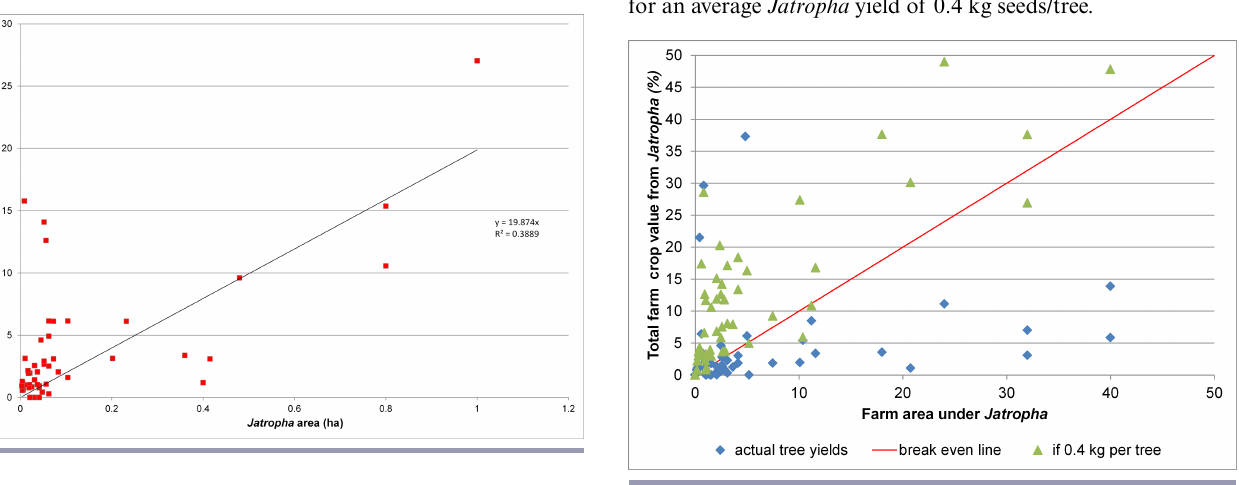
Fig. 2 . Income of BERL farmers from Jatropha sales (based on the first season harvest until the time of the survey in March 2013).